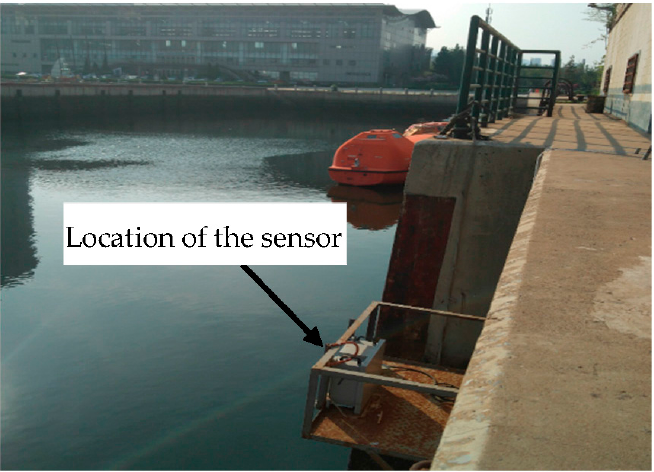
Figure 7. Location of the sensor in Lingshui port, China.